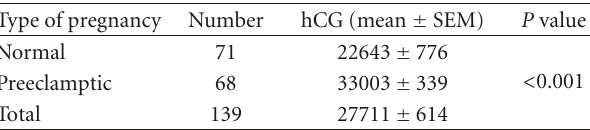
Table 4: Comparison of mean serum hCG level between normal and preeclamptic pregnancies.